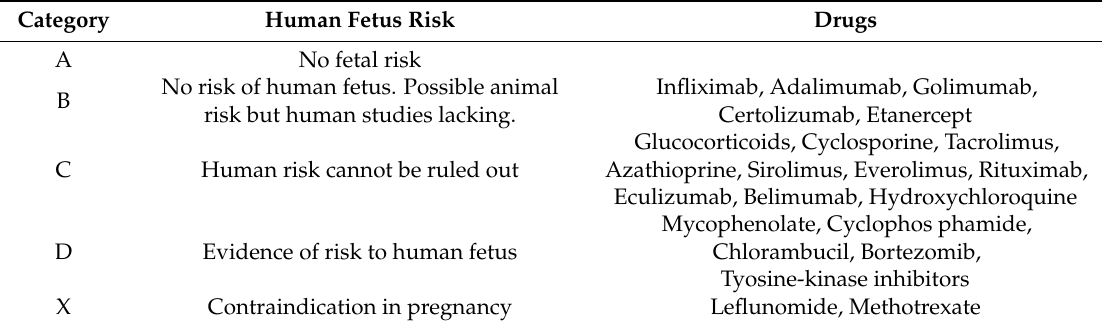
Table 1. The food and drug administration classification of teratogenic